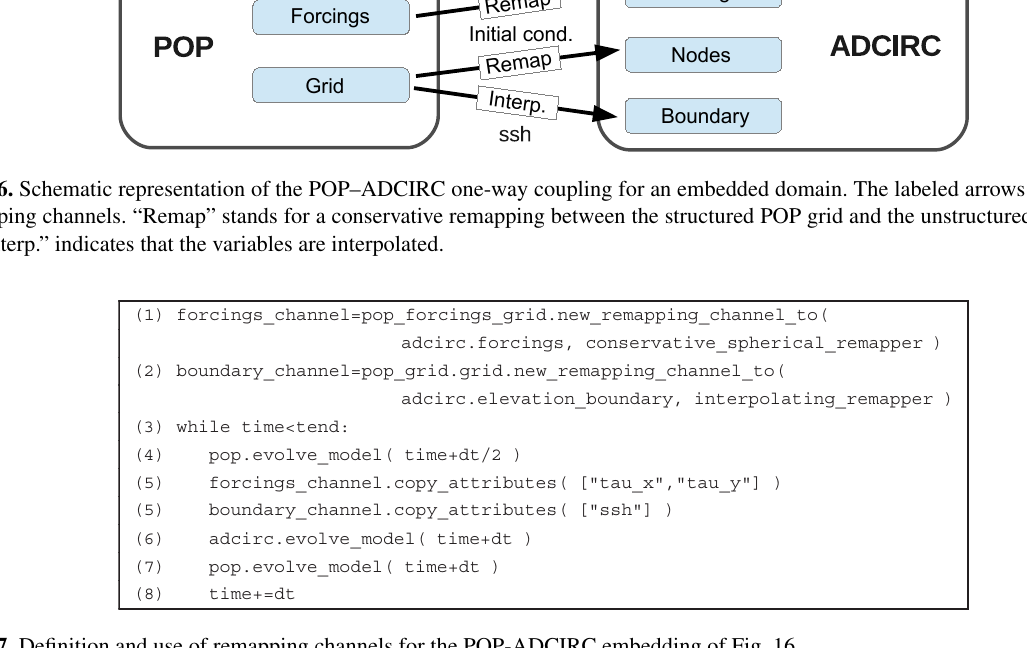
Figure 17. Definition and use of remapping channels for the POP-ADCIRC embedding of Fig. 16.